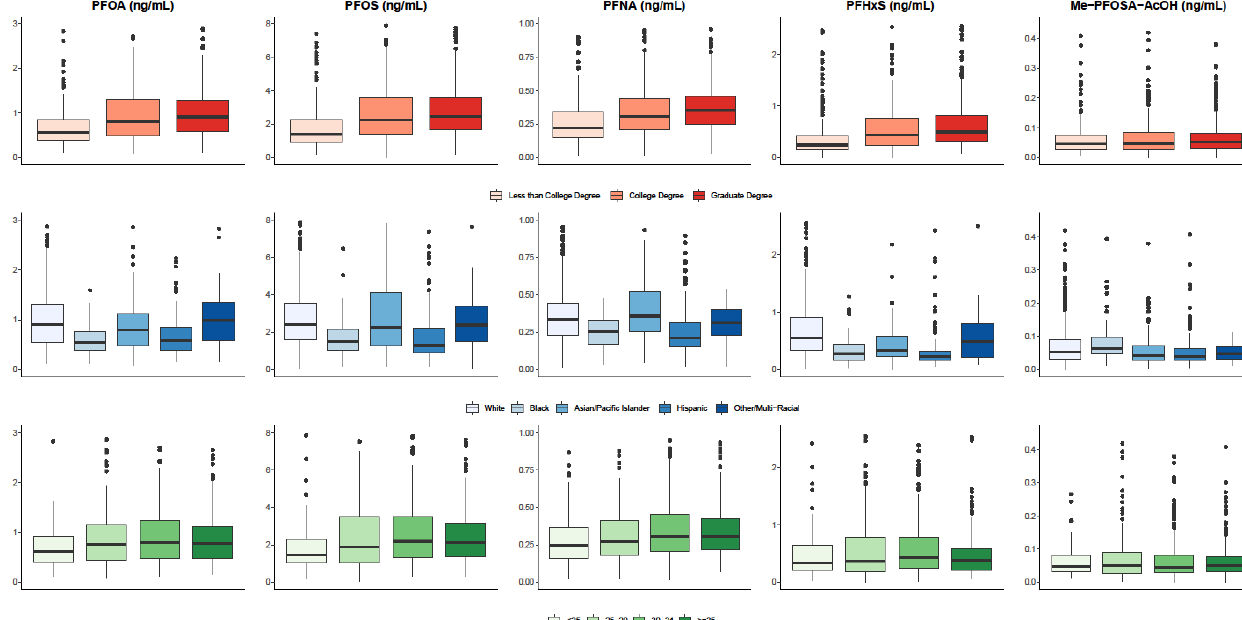
Figure 2. Distribution of PFAS (ng/mL) levels with >95% detection across selected demographic characteristics.